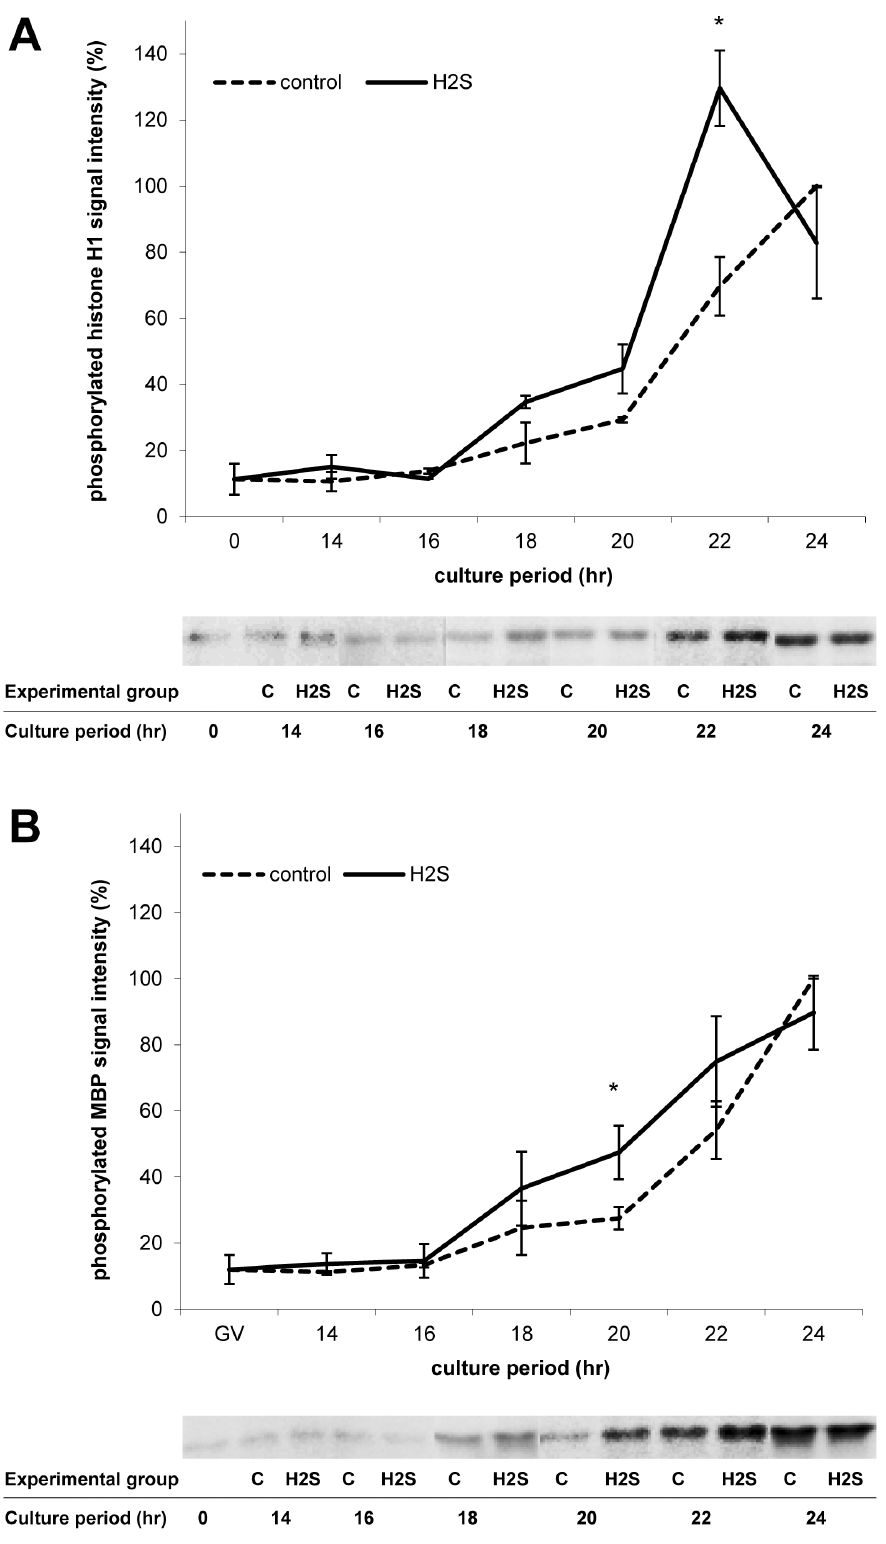
Figure 3. Effect of Na 2 S on MPF and MAPK activities during oocyte cultivation. Representative autoradiograms and signal quantifications of phosphorylated histone H1 (A) and MBP (B) reflecting MPF and MAPK activity, respectively. Kinase activity was measured in oocytes cultivated with or without Na 2 S over 2 h time scale. The kinase activity was related to oocytes cultivated for 24 hs. C: control; H 2 S: 300 m M Na 2 S. *Statistically significant differences between control and H 2 S groups (P , 0.05).